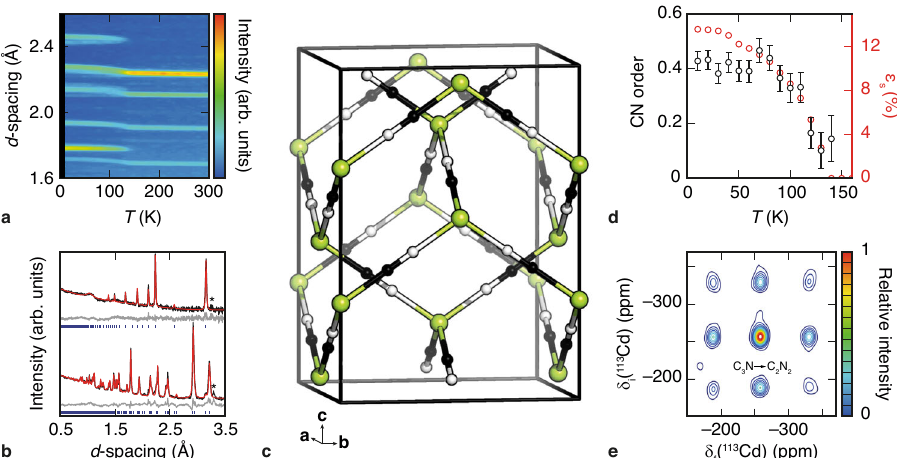
Fig. 2 Evidence of CN – fl ips in Cd(CN) 2 . a Intensity map of the temperature-dependent neutron powder diffraction pattern of 114 Cd(CN) 2 , showing the existence of a phase transition at T c = 130 K. b Rietveld fi ts to the diffraction pattern at representative temperatures above (top, Pn (cid:1) 3 m ) and below (bottom, I 4 = amd ) T fi ts in red, difference in grey and re fl ection positions as blue vertical bars. The contribution from a minor Hg(CN) c . Data are shown in black, 1 impurity 39 is indicated by asterisks. c Representation of the I 4 1 = amd crystal structure of Cd(CN) 2 at 10 K: Cd atoms are shown in green, C in white, and N in black. Thermal ellipsoids (isotropic) are shown at 50% probability. d Temperature evolution of the spontaneous strain (red circles) and long-range CN – orientational order (black circles) determined by Rietveld re fi nement; error bars denote the standard errors obtained from re fi nement and, for the strain, are smaller than the symbols. The emergence of CN – order implies that CN – fl ips occur. The divergence of the strain and orientational order parameters marks a glass transition at T g ’ 80 K. e Contour plot of the 113 Cd EXSY spectrum of natural-abundance Cd(CN) 2 at 60 °C showing the correlation between resonances collected before (subscript ‘ i ’ ) and after (subscript ‘ f ’ ) a mixing period of 1 s. Intensities are scaled relative to the maximum value, and contour levels are indicated on the accompanying colour spectrum. The existence of off-diagonal correlations proves the activation of CN – fl ips, such as those which interconvert CdC 3 N and CdC 2 N 2 coordination environments